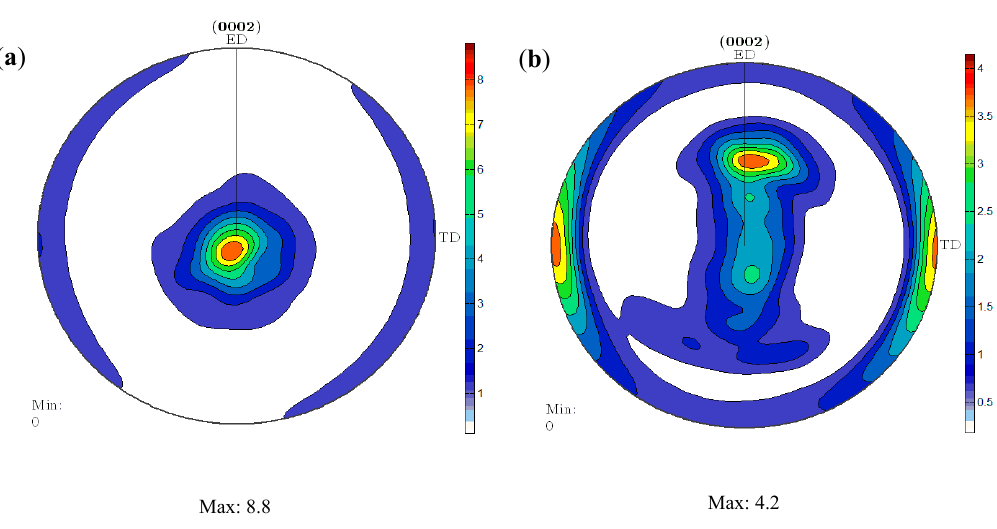
Figure 6. The (0002) pole figures of ECAPed Mg-9Al-1Si-1SiC composites: ( a ) without HT; ( b ) with HT.